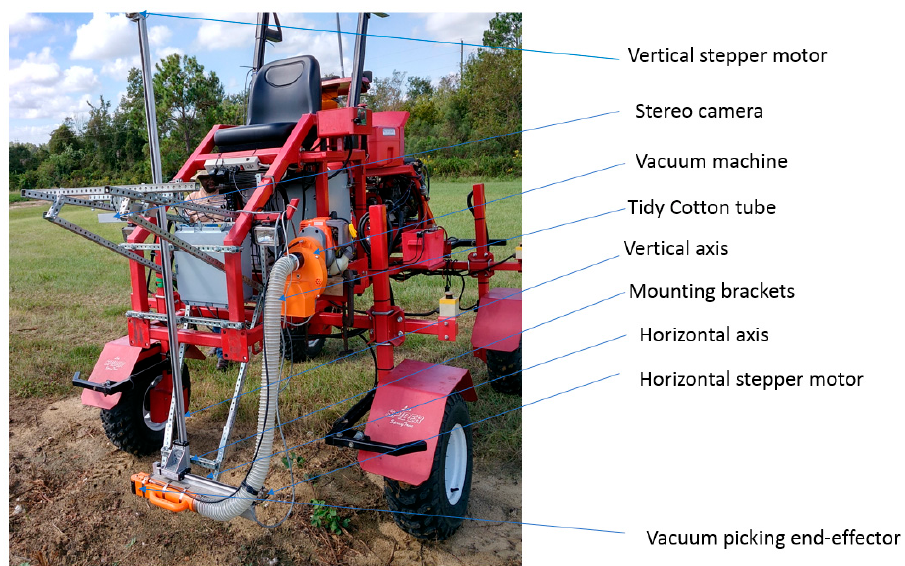
Figure 6. The cotton robotic system proposed by our team [96,97].